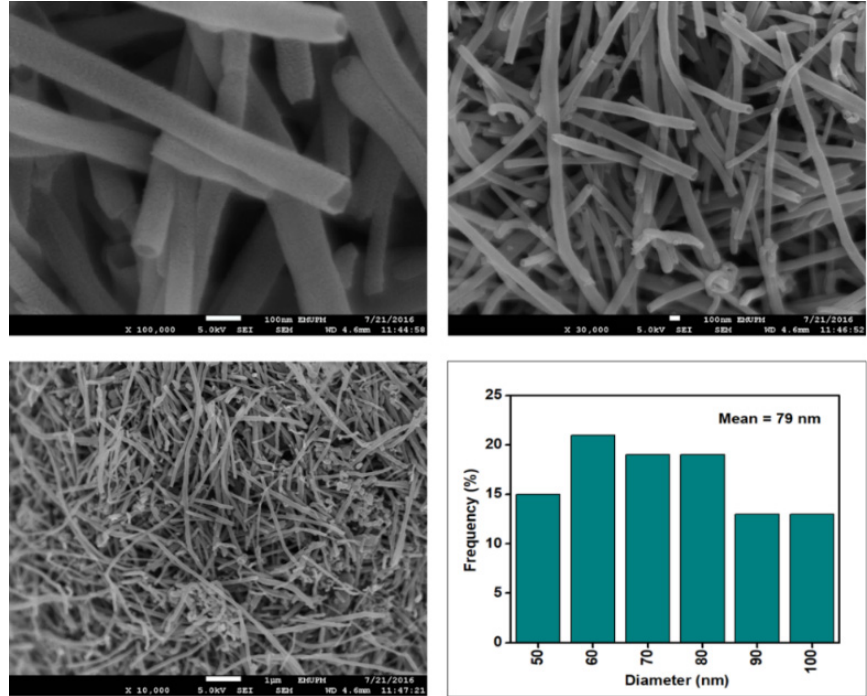
Figure 6. FESEM imaging of the commercial CNF at 100, 30, and 10 resolutions and their corresponding diameter distribution histogram (mean diameter = 79 nm).